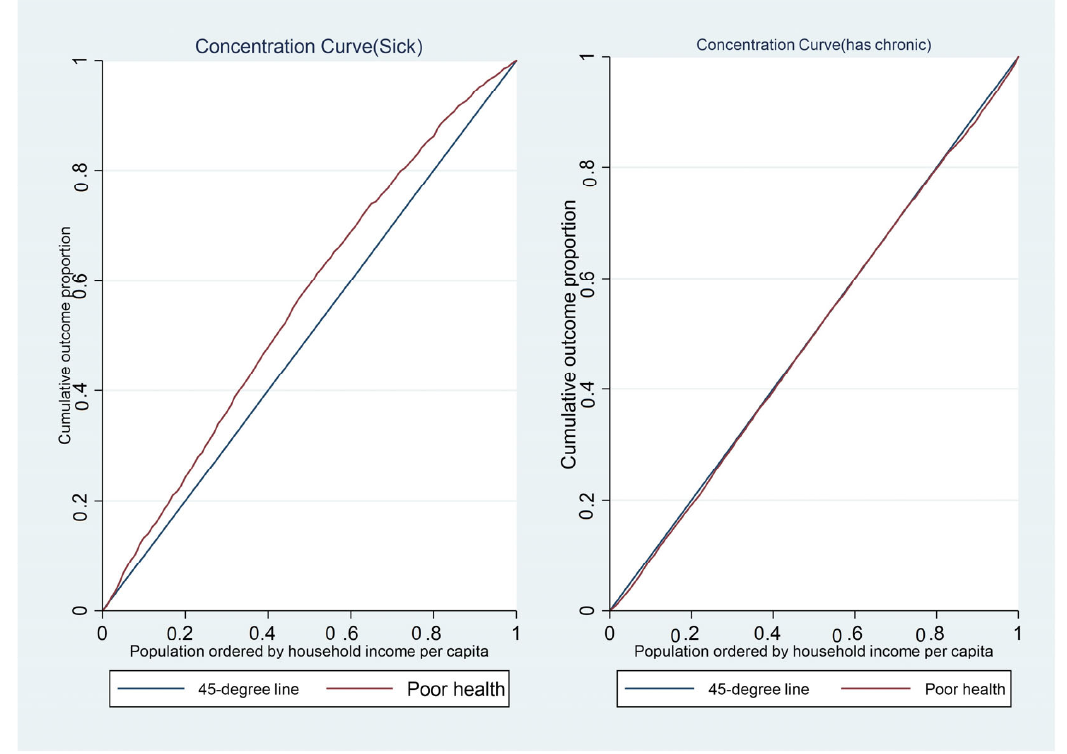
Figure 1. The concentration curves for being sick and for having a chronic disease.